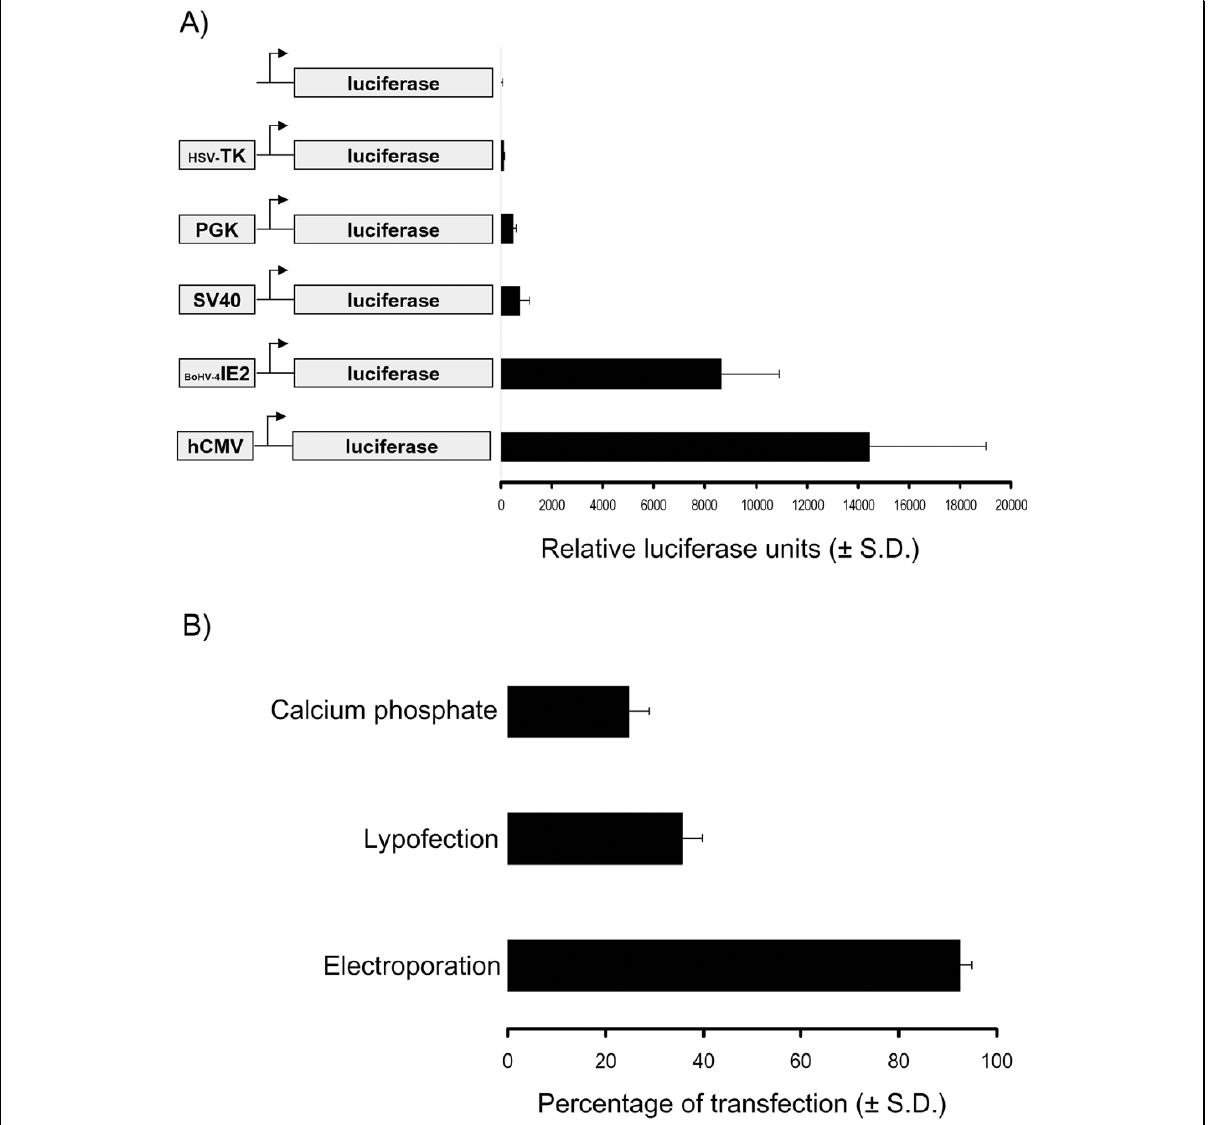
Figure 1 Promoters activation in EADSCs . A) Transiently transfected EADSCs with constructs containing promoter in front of the luciferase reporter gene or pGL3 empty vector (diagrams not on scale) as a control, at 24 h post transfection. The results are expressed as the mean relative Luciferase units after normalizing with efficiency of transfection. Each reaction was done in quadruplicate, and each point represents the average ± standard deviation from three experiments. B) Efficiency of EADSCs transfection obtained with different transfection methods, using pEGFP-C1 as a reporter plasmid. Each transfection method was done in quadruplicate, and each point represents the average ± standard deviation from three experiments. EGFP was monitored by fluorescence microscope and quantified by flow